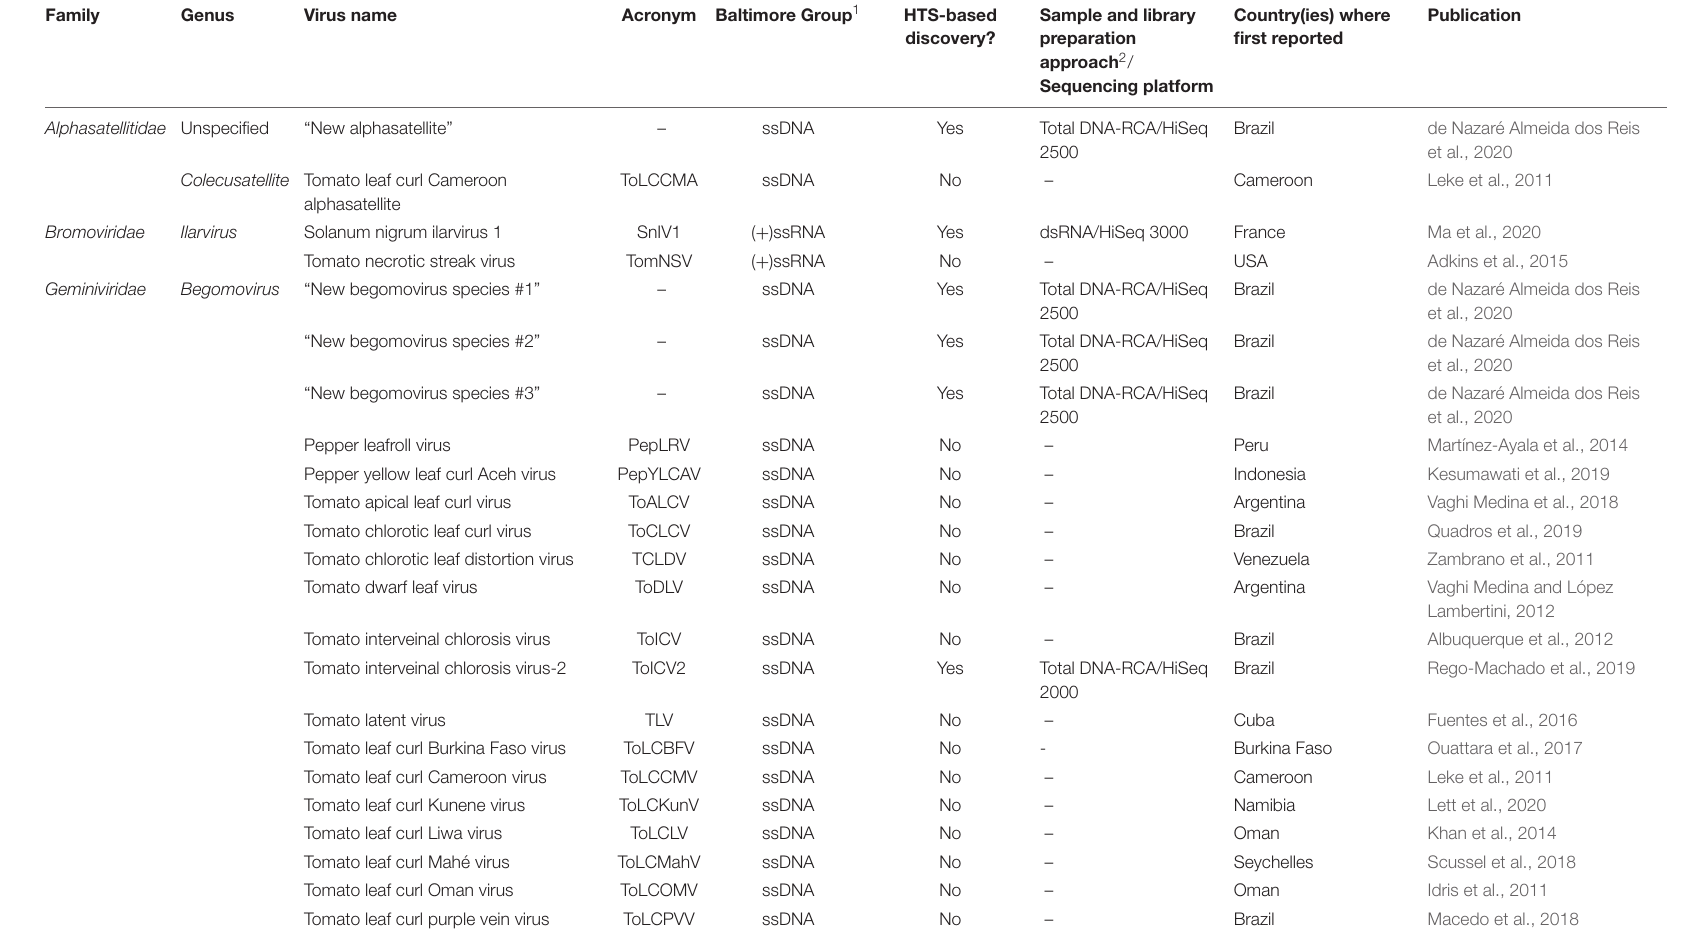
TABLE 1 | Novel virus species discovered from 2011 to 2020 and associated with